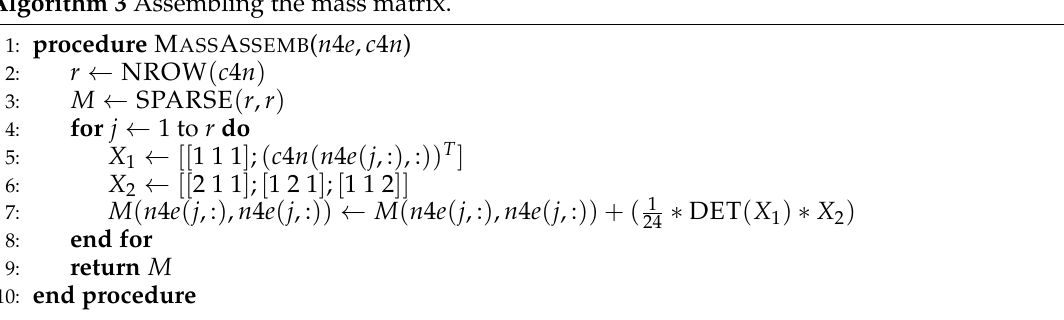
Algorithm 3 Assembling the mass